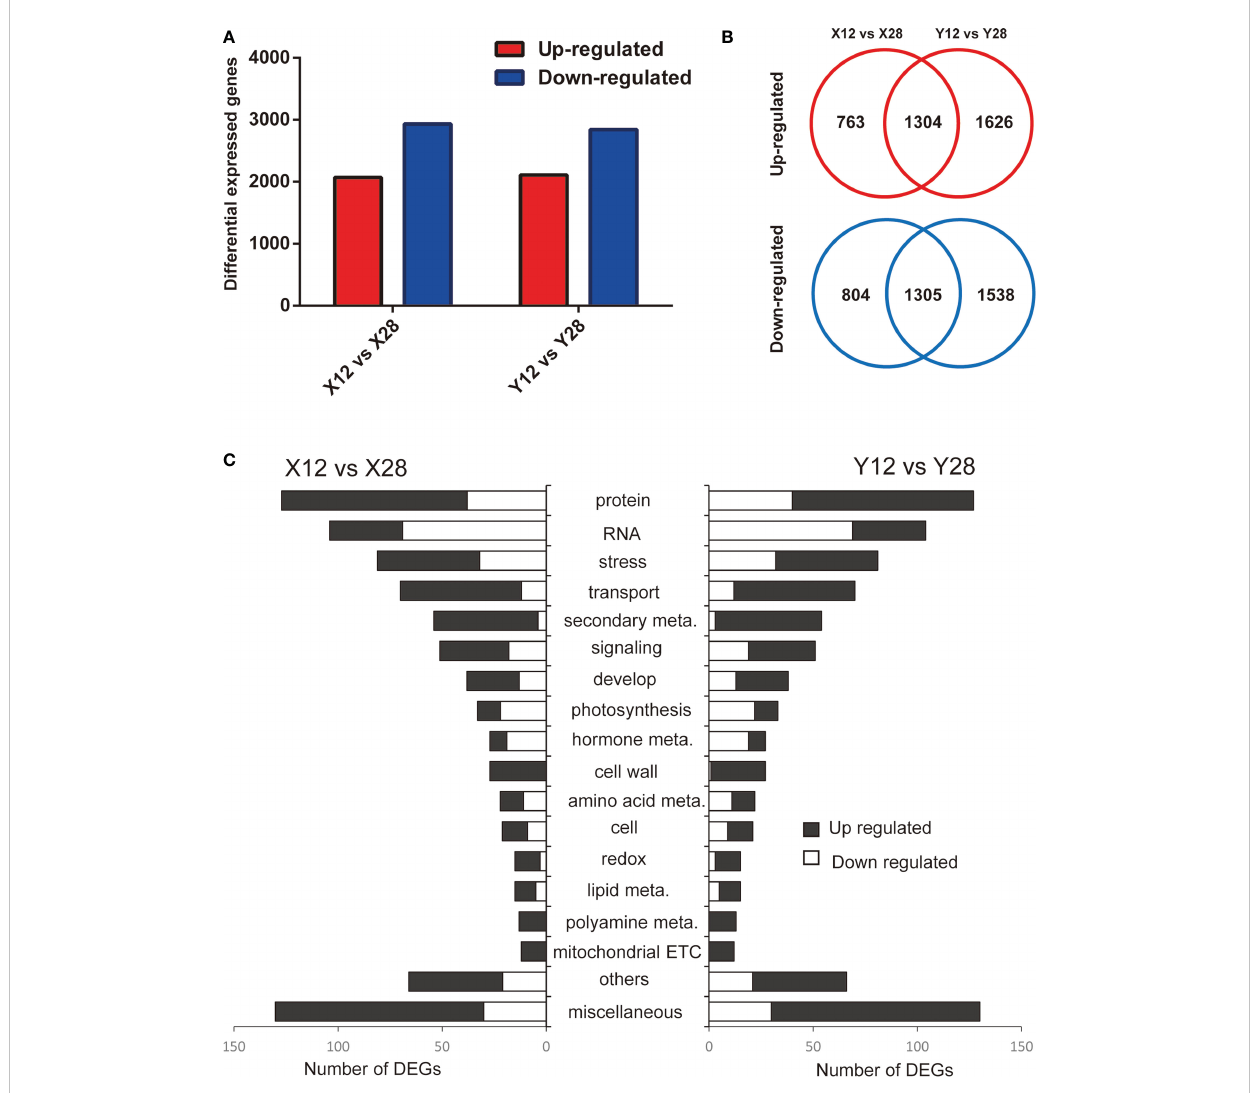
FIGURE 2 Overview of identi fi ed DEGs responding to cold treatment in different species of tobacco. (A) DEGs in XY1 and YY85 under cold stress treatment. (B) Up-regulated and down-regulated overlapped genes in XY1 and YY85 under cold stress treatment. (C) The DEGs were classi fi ed based on Mapman